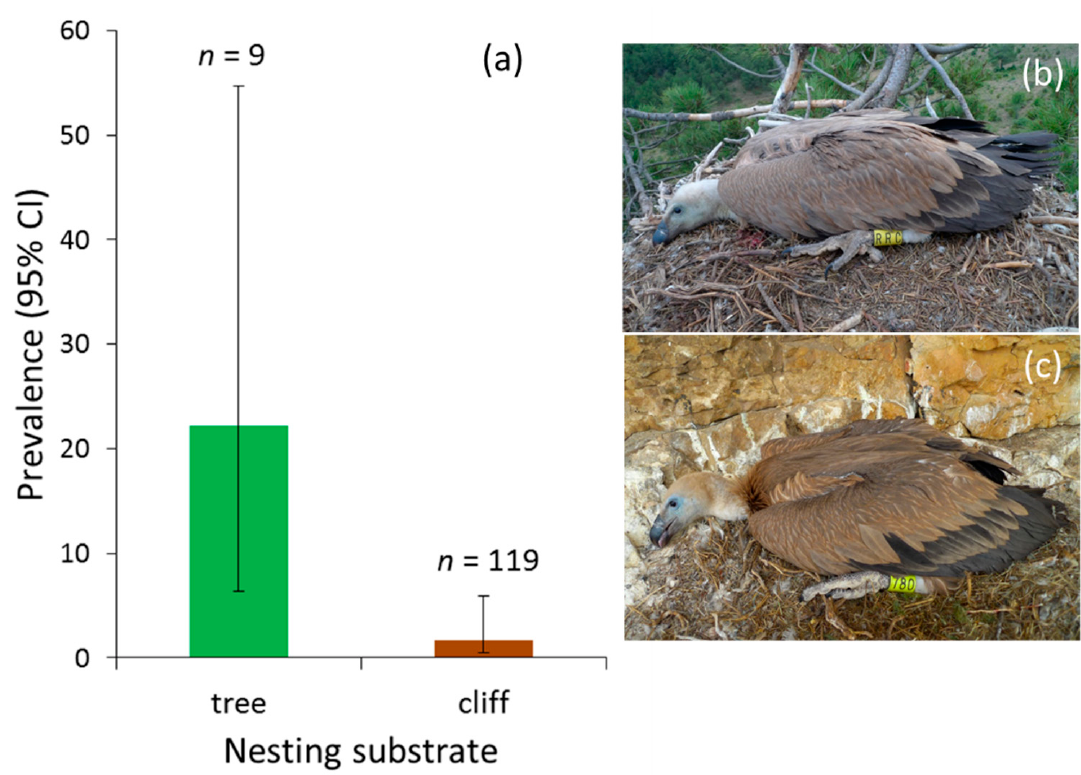
Figure 1. ( a ) Prevalence ( ± 95% CI) of haemosporidians in nestling griffon vultures from nests built by cinereous vultures in maritime pines ( b ) and cliffs ( c ). Table 2. Generalized linear models (GLMs) of body mass of nestlings of three vulture species sampled in central Spain. Parameter estimates for the levels of fixed factor and their standard errors were calculated considering the category of reference indicated in